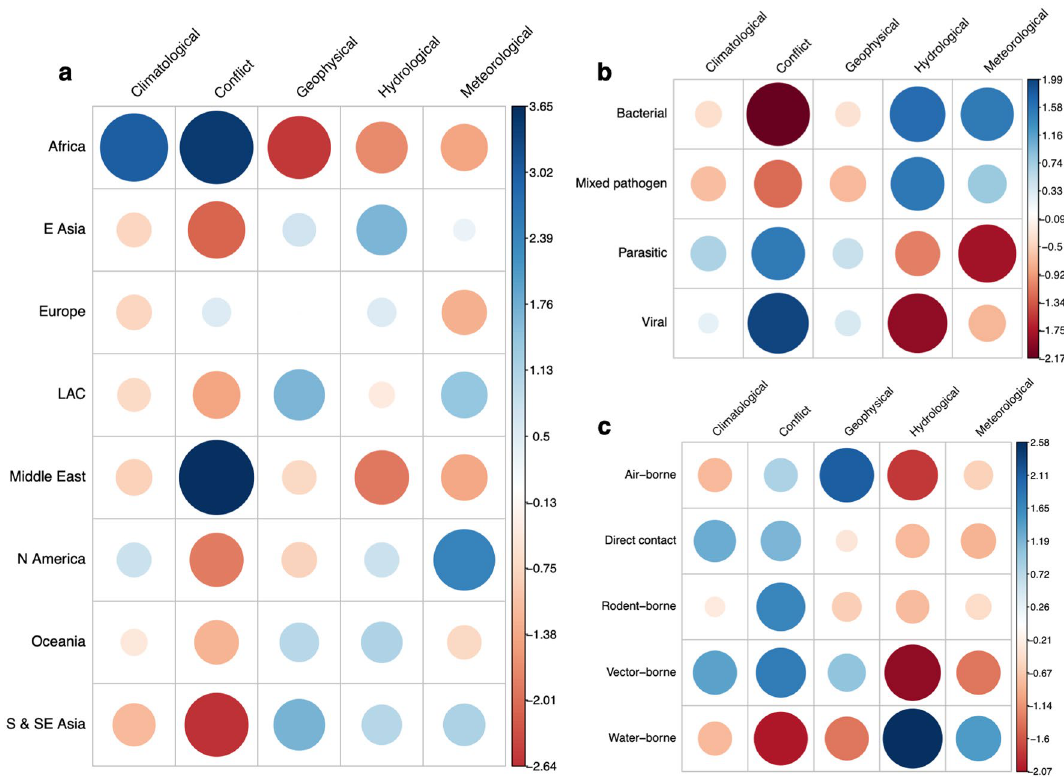
Figure 4. Correlation plots for the Pearson’s chi squared test residuals for each catagories in a , region against disaster (X-squared = 101.81, df = 28, P -value ≤ 0.05), b , disease against disaster (X-squared = 31.49, df = 12, P -value ≤ 0.05) and c , disease transmission against disaster (X-squared = 47.31, df = 16, P -value ≤ 0.05). Positive residuals are blue, suggesting a positive association between the corresponding row and column and negative residuals are red, suggesting a negative